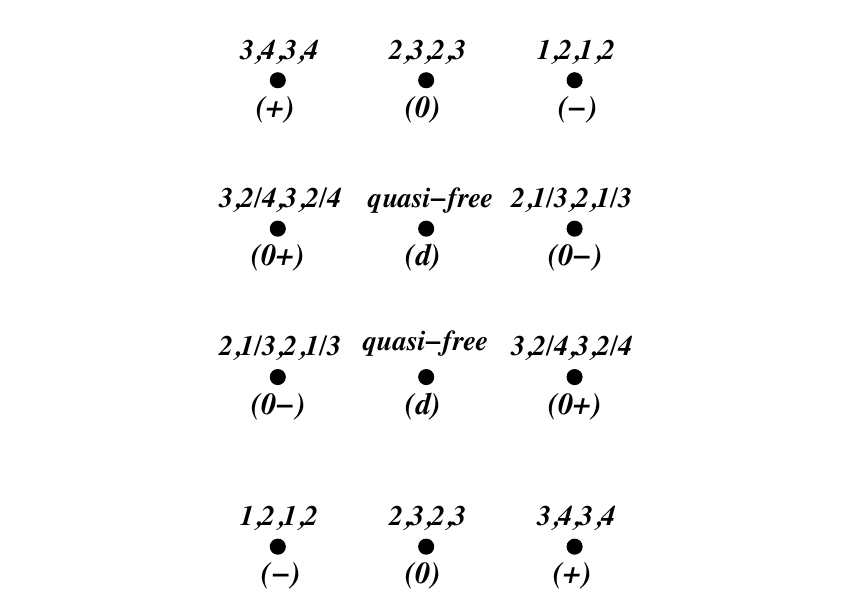
Figure 3: Correspondence between boundary conditions in lattice models and Kac labels of conformal boundary states: in the A model according to Ref. [ 14 ] (upper labels), and in the 4 Blume-Capel model, according to Ref. [ 16 ] (lower